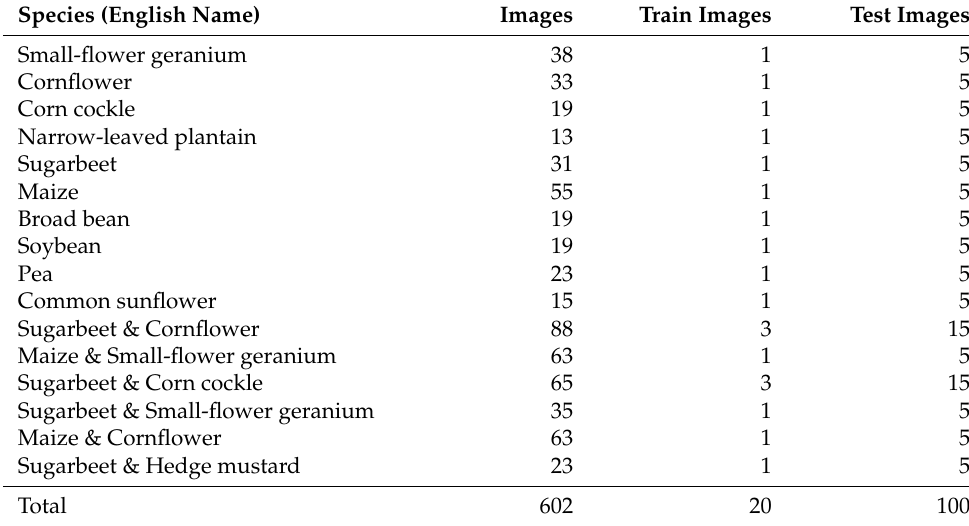
Table 2. Overview of image dataset collected in 16 field parcels with a total of 11 plant species covered. Table shows the number of images in the database, as well as the number of randomly selected training and test images per